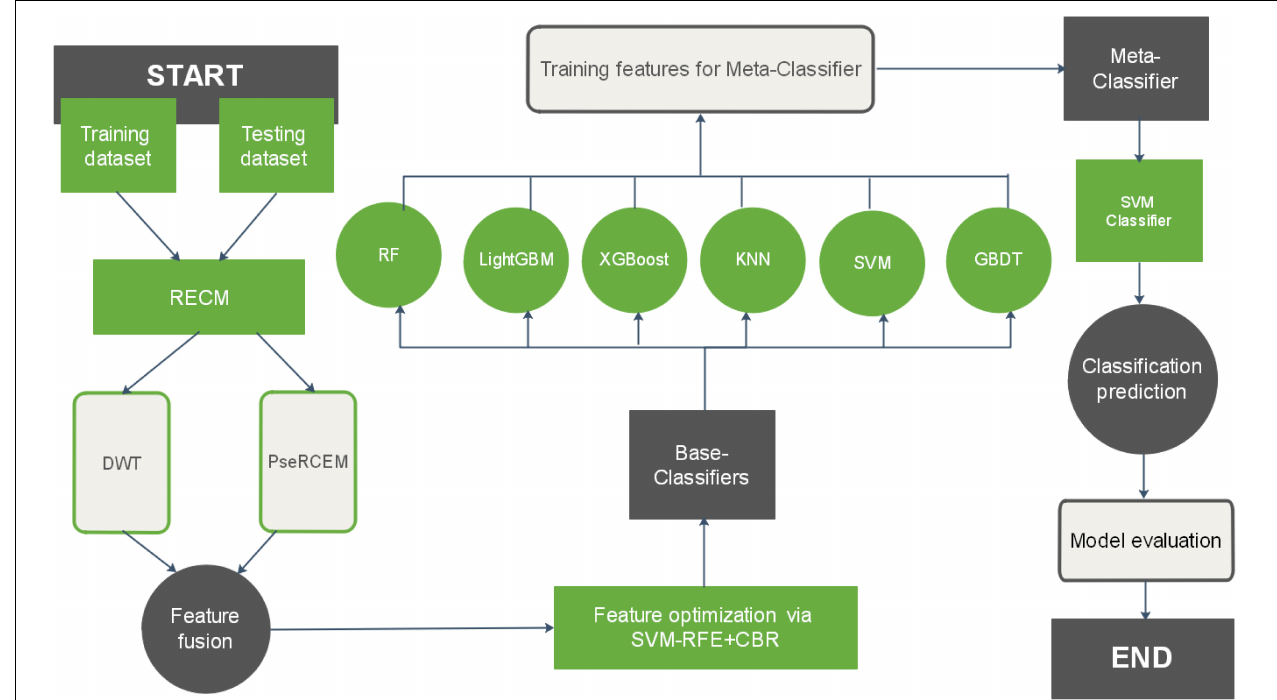
FIGURE 1 | Overview of the StackRPred